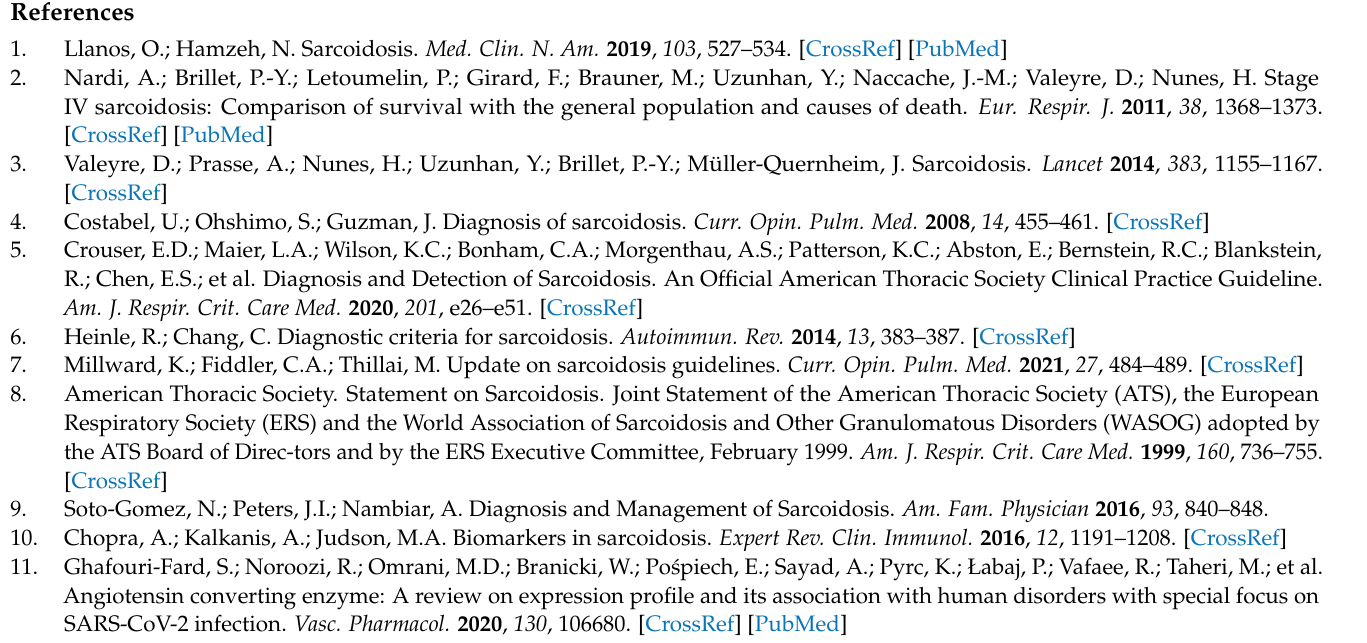
method (spectrophotometric vs. other), diseased region (ocular sarcoidosis vs. other), and ethnicity (Caucasian vs. Asian). Figure S4: Deek’s funnel plot to assess risk of publication bias. Figure S5: Forest plots of sensitivity and specificity of the sACE for diagnosing ocular sarcoidosis. Left: sensitivity; right: specificity. Figure S6. Receiver operating characteristic curves showing the performance of the sACE for diagnosing ocular sarcoidosis. Table S1: The clinical summary of included studies for ocular sarcoidosis. Table S2: The diagnosis performance of sACE by ethnicity in sarcoidosis